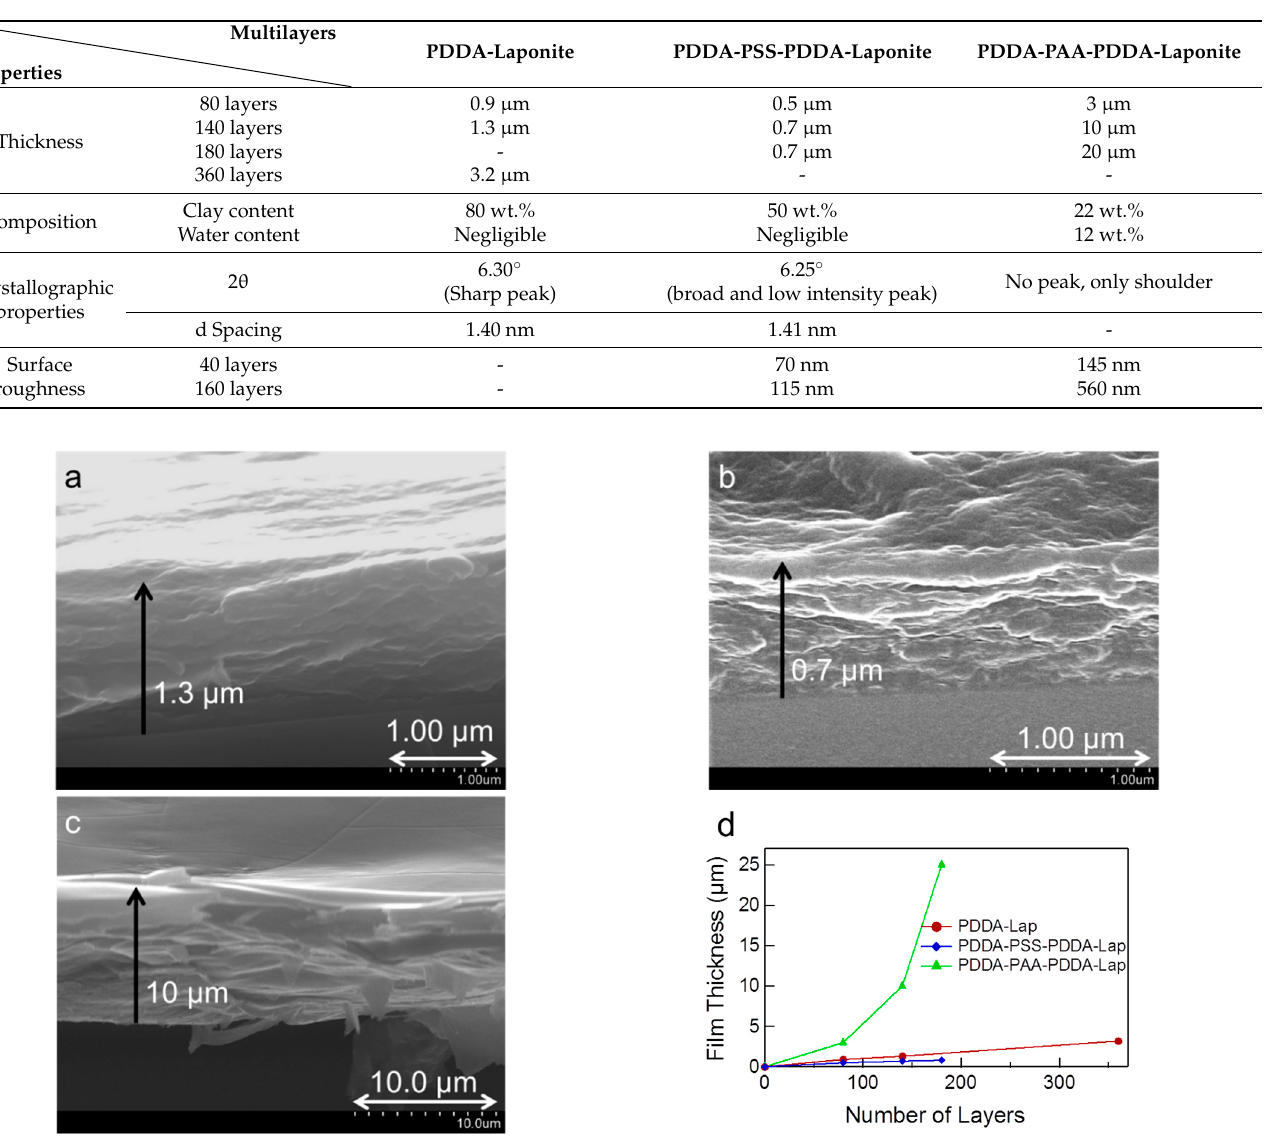
Table 1. Comparison of structural properties among the three clay-containing multilayers.